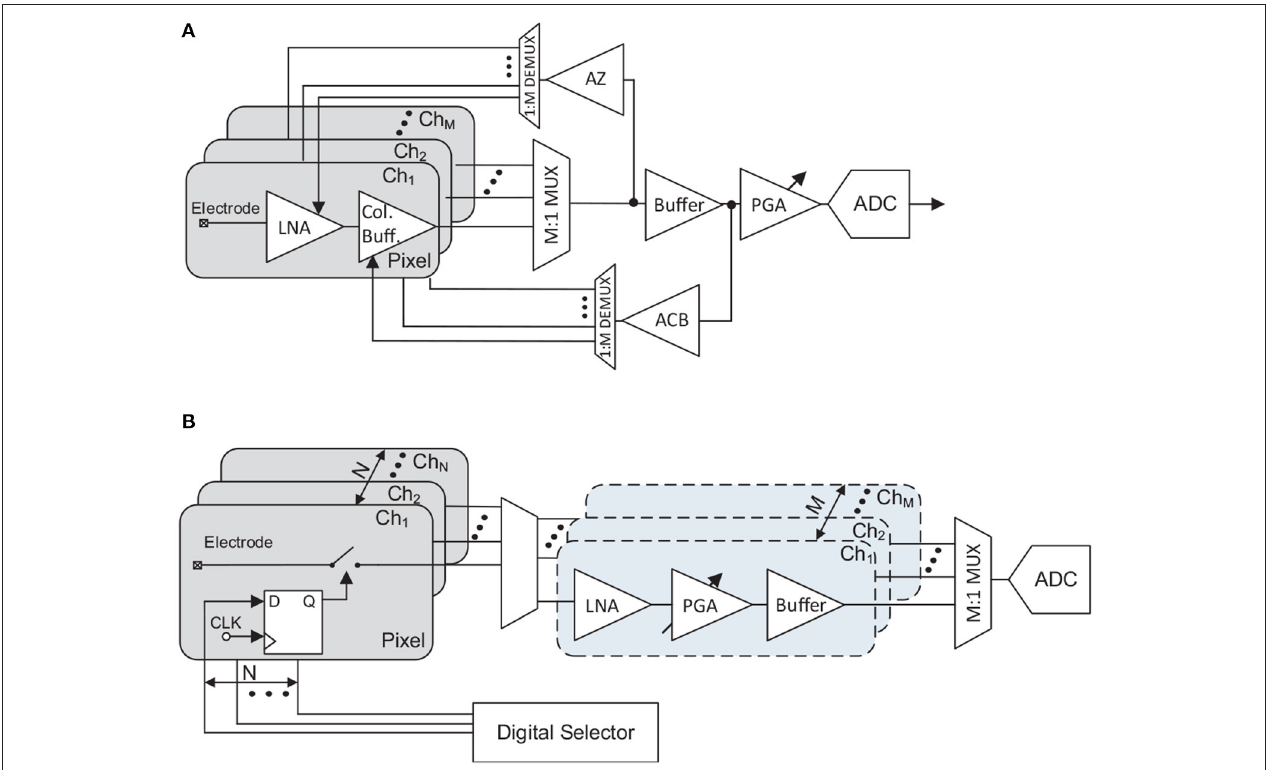
FIGURE 9 | Examples of PGA sharing and switch array AFE topologies. (A) Block diagram of the PGA sharing AFE topology presented in Angotzi et al. (2018). (B) Block diagram of the switch array AFE topology presented in Dutta et al.